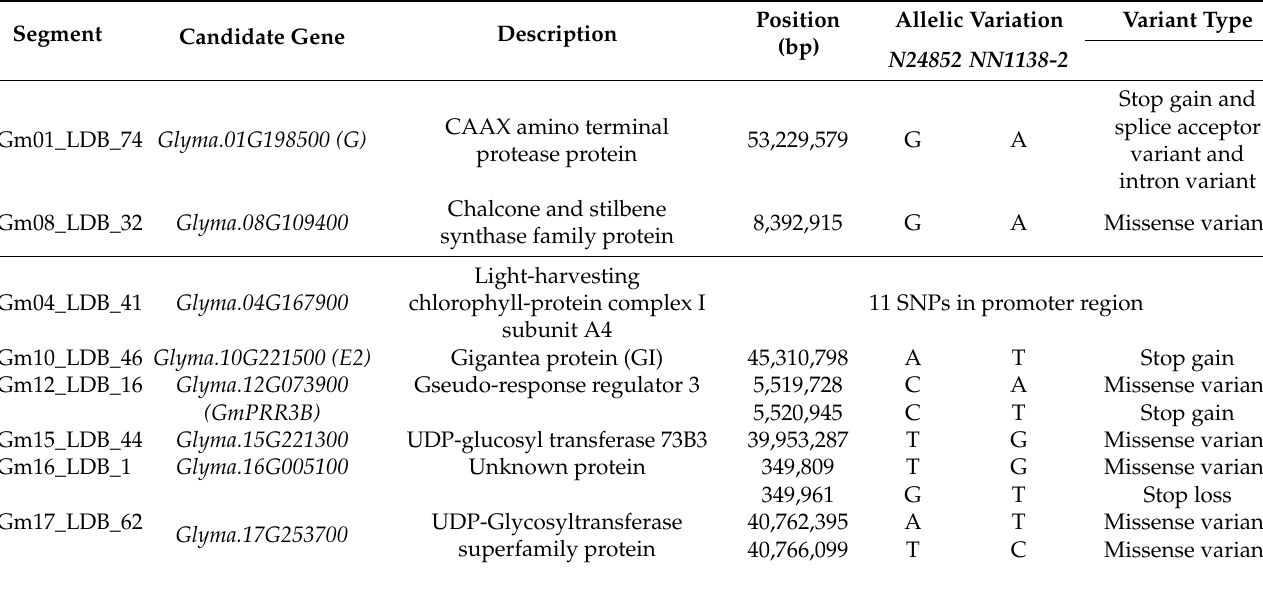
Table 4. Annotation of candidate genes for SCC and DTF based on the sequence differences between NN1138-2 and N24852. Segment Candidate